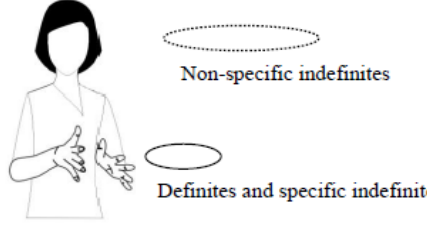
Figure 2. Definiteness and specificity marking on LSC frontal